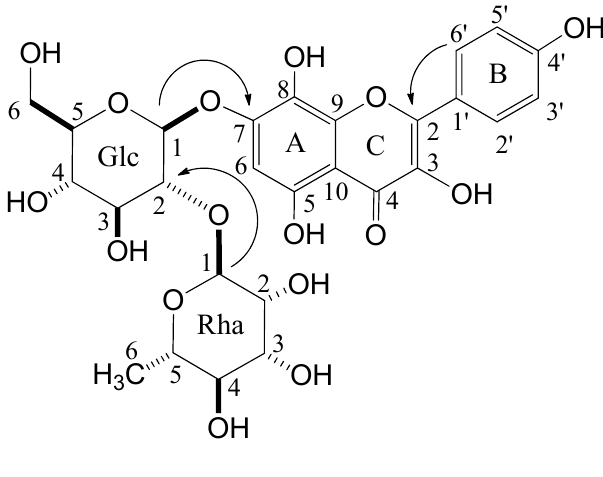
Figure 2. Key HMBC correlations of compound 1